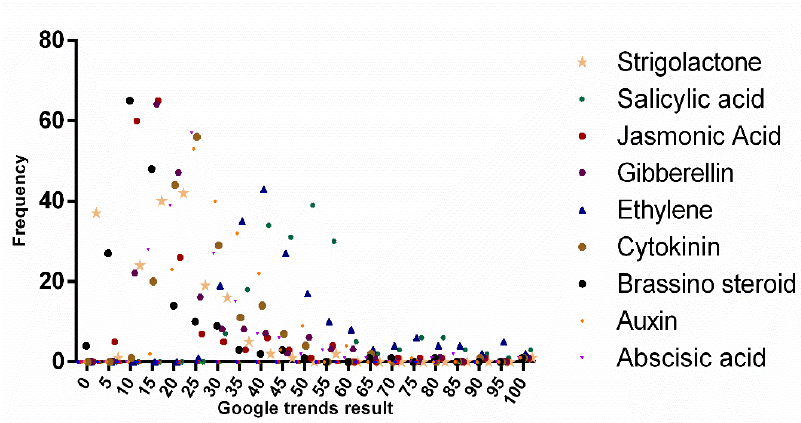
Figure 3. Frequency distribution of different phytohormones. Google trend search data over time was considered to draw the graph. The graph shows various phytohormone search results of Google trends found dynamically. However, a very few numbers of (~ < 20) Google trend results were found with a score more than